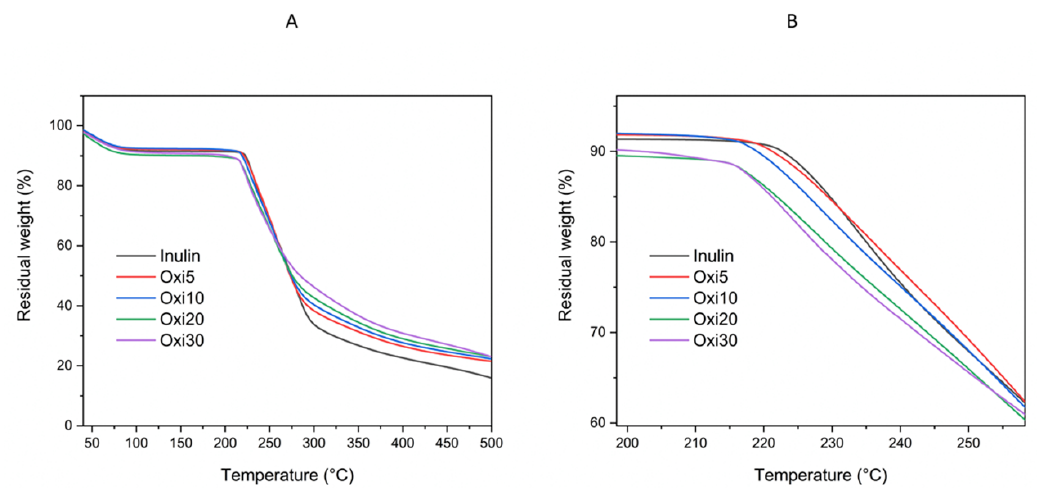
Figure 5. ( A , B ) TGA thermograms of unmodified raw inulin and Oxi5, Oxi10, Oxi20, and Oxi30 samples.